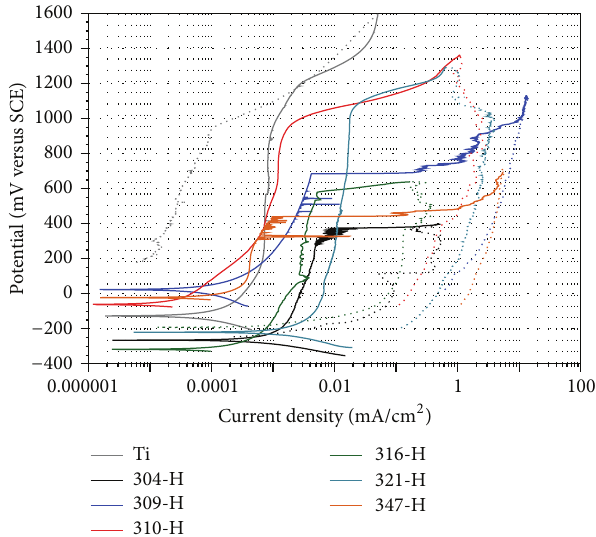
Figure 5: Cyclic polarization curves recorded for materials in artificial saliva at 37 ∘ C, dE/dt = 0.167mV/s.